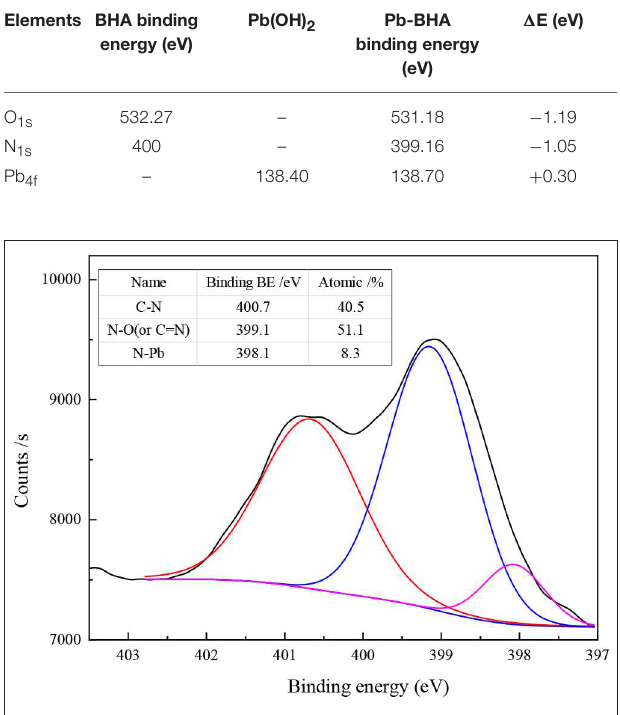
rings and “N, O” four-membered rings. In the presence of more BHA, a single lead ion can form a complex with two BHAs. Therefore, multiple components of the Pb-BHA complexes exist in the liquid phase, which may be adsorbed on the mineral surface together (Xia et al., 2004; Zhu and Zhu, 2012).